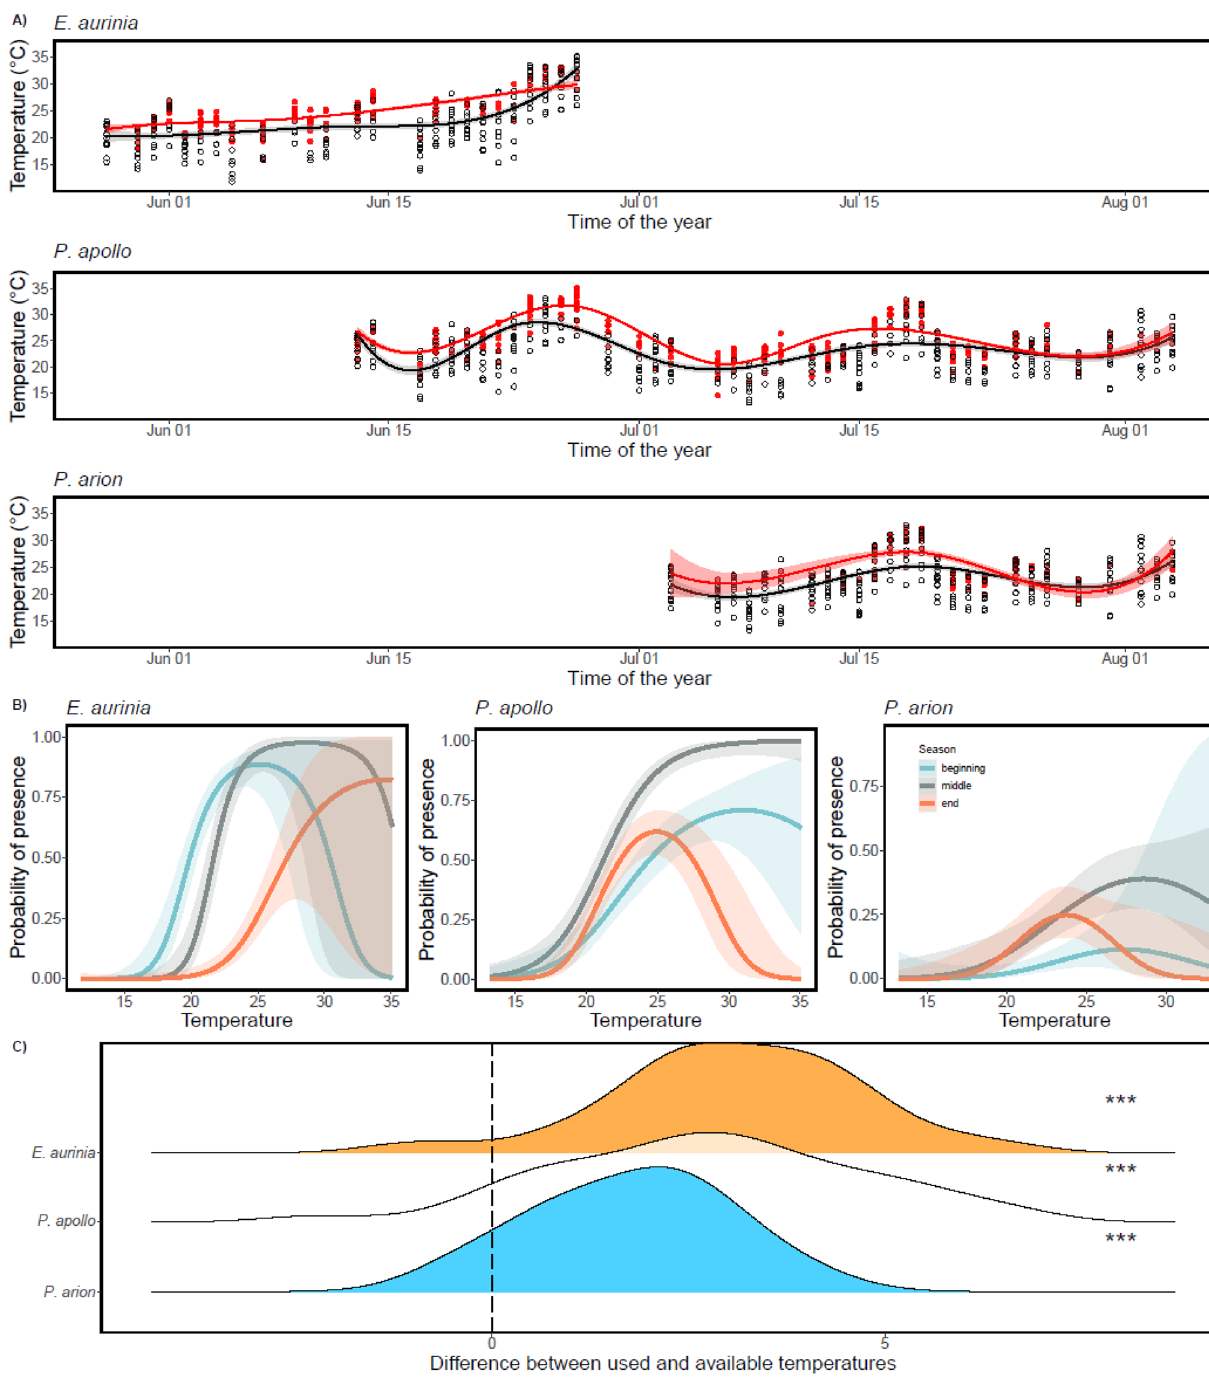
Figure 2. Seasonal variation in realized thermal niches to available ambient temperatures for three butterfly species. ( A ) Ambient temperatures when butterflies were active/caught (shown in red) and temperature recordings when no butterflies were found (open black circles). The fitted spline curves denote occupied temperatures (red) and all available temperatures (black). ( B ) Comparisons of reaction norms linking activity (probability of presence) to available ambient temperature in the beginning, middle, and end of the activity period for each species (see methods). The interaction is statistically significant for Marsh Fritillary ( Euphydryas. aurinia) and Apollo ( Parnassius apollo ). ( C ) Distribution of the averaged daily difference between used and available temperatures for each species. Significance levels from one-sample t -test. *** denotes p <